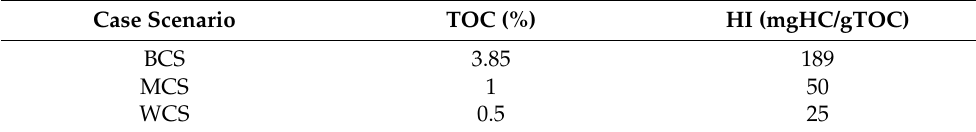
Table 1. Dividing data of the case scenarios concerning the offshore models. The BCS and WCS were introduced based on cutting samples of a neighboring well (SK-1), and the MCS from the Rock Eval analysis performed on the outcrop